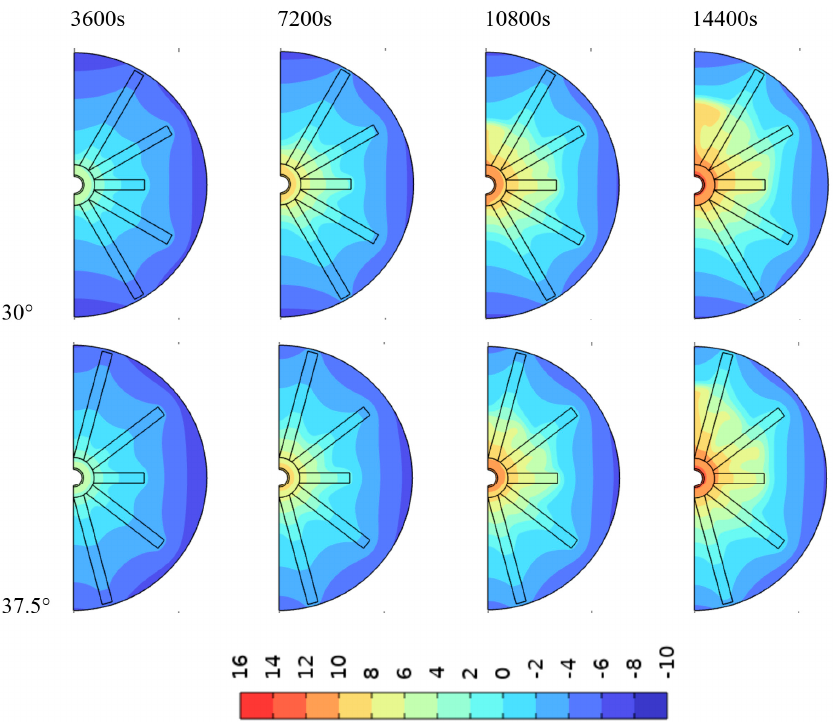
Figure 8. The temperature difference distribution (°C), T − T f , maps at different time steps for two cases of δ = 30° and δ = 37.5° when ε = 0.95 and ω = 1% wt.